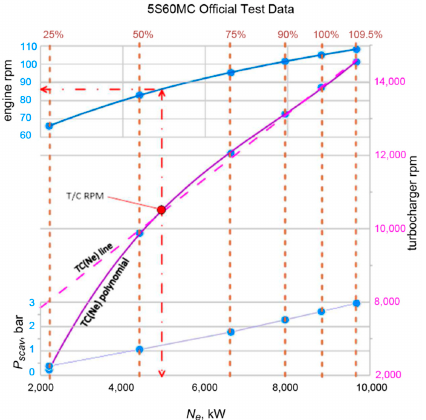
Figure 2. The main engine 5S60MC official test data ( engine RPM , TC rpm , P scav ). At engine operation the compressor impeller blades generate oscillations in the gen- eral spectrum of vibrations regardless of the turbocharger’s technical conditions, as was experimentally proven [5,8,11]. Spectral analysis shows that the acoustic signal from the compressor blades has a frequency equal to the turbocharger rotor speed multiplied by the number of blades (see Figure 3):